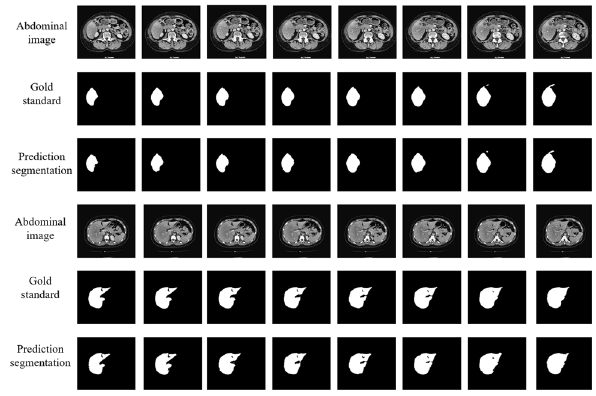
Fig. 7 Comparison of model prediction segmentation and gold